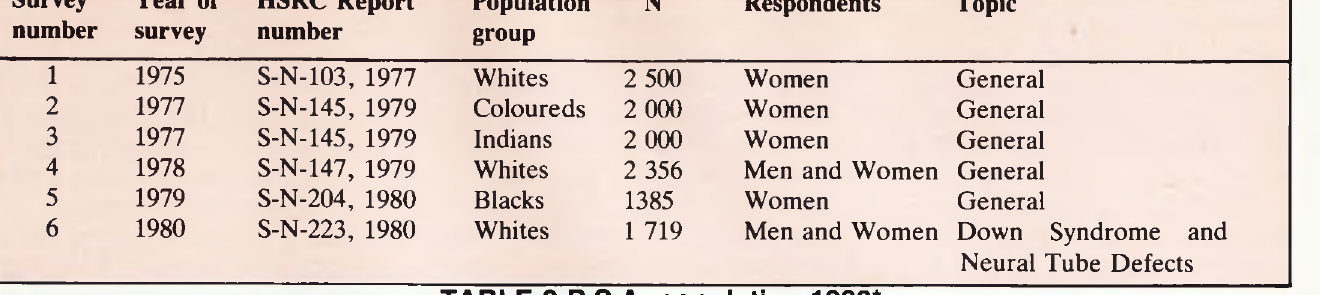
TABLE 2 R.S.A. population